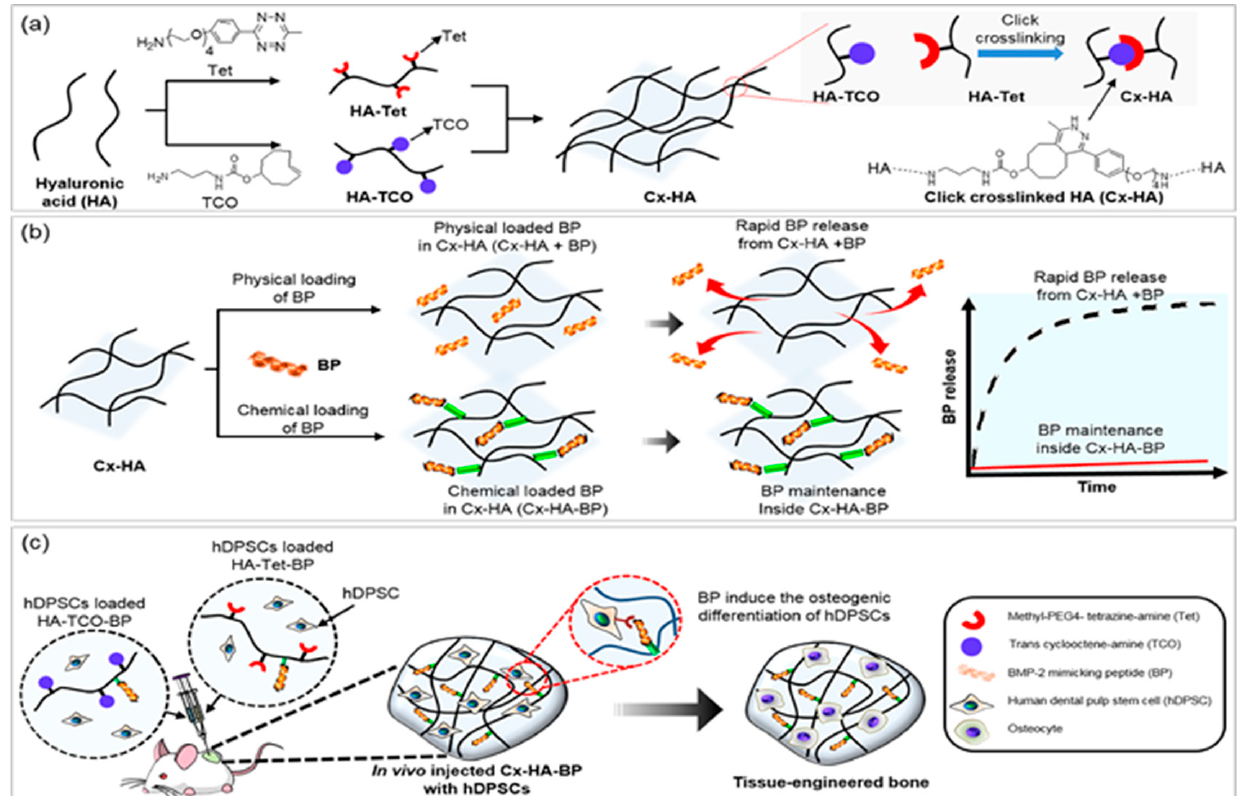
Figure 13. Schematic illustration for the preparation of ( a ) HA-Tet, HA-TCO, and Cx-HA ( b ) the release pattern for of BP from Cx-HA(+BP) and Cx-HA-BP; ( c ) osteogenic differentiation of hDPSCs on Cx-HA-BP (adapted with permission from Zhang et al., 2012).